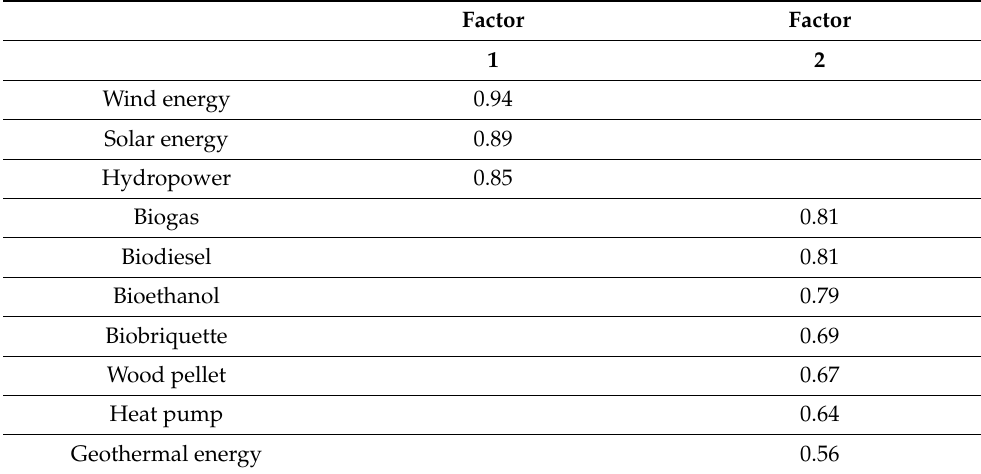
Table 9. Factors of the relationships among the awareness of the energy sources studied. Factor Factor